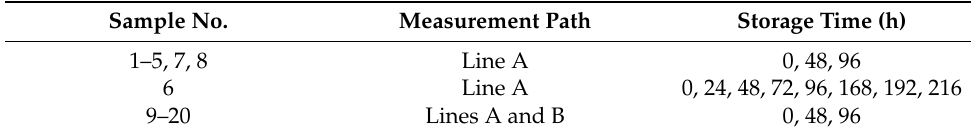
Table 2. Measurement paths and storage times of mangoes. Sample